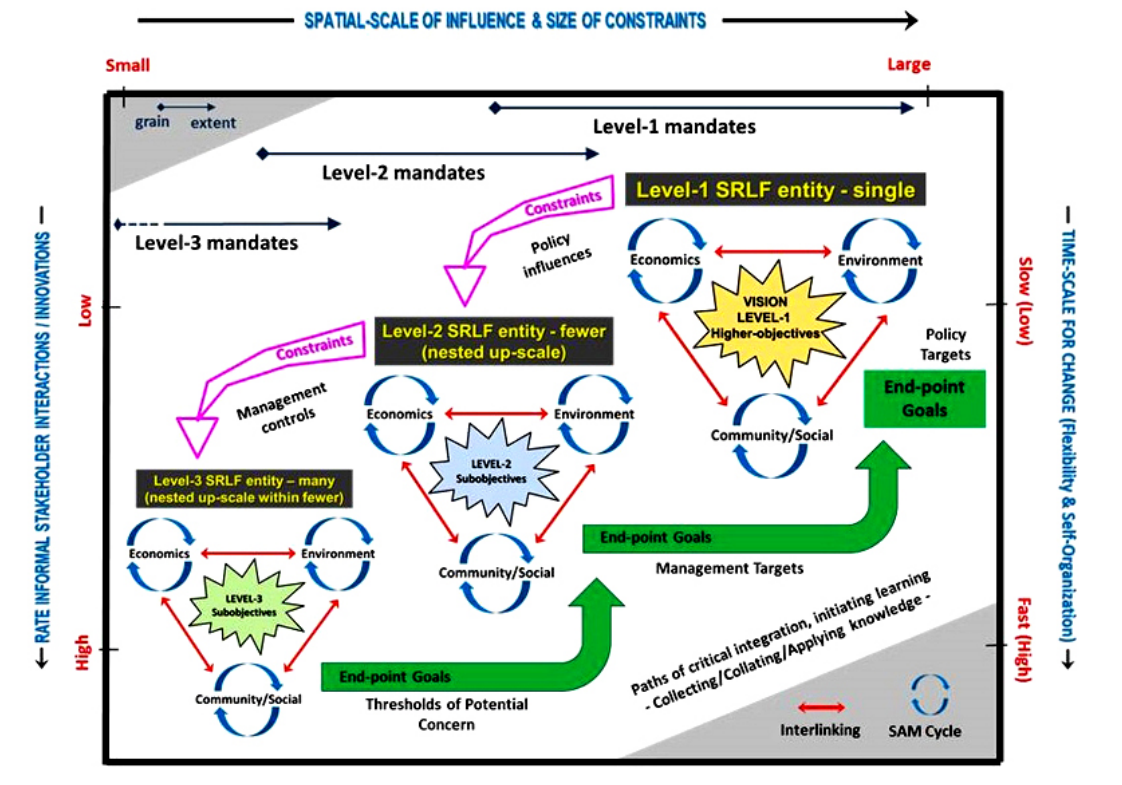
Fig. 2 . The Strategic adaptive management (SAM) Reflexive Learning Framework (SRLF) exhibits a nested, hierarchical structure, across three levels of governance. A SRLF entity comprises interlinked SAM cycles for the Environment, Economic, and Community/Social themes. Typically, there are many Level-3 entities nested within fewer parent Level-2 entities, and these all nest within the single Level-1 entity. The Vision statement, derived at Level-1, is broken down into the Higher-objectives (per theme) at Level-1. These Higher-objectives culminate in Policy Targets at Level-1. Policy Targets cascade down into more detailed Level-2 Subobjectives, culminating in Management Targets at Level-2. Management Targets cascade down into finer detailed Level-3 Subobjectives, culminating in Thresholds of Potential Concern (TPCs) at Level-3. “Top-down” processes in SRLF include policy influences that constrain the types of Level-2 management approaches allowed. In turn, management approaches selected control the types of Level-3 actions required. The main “bottom-up” process involves learning. Learning is initiated primarily during the TPC feedback processes occurring within Level-3 entities. Information/knowledge is collated up to parent Level-2 entities to inform the Management Targets; similarly information/knowledge is collated up to the parent Level-1 entity to inform Policy Targets. Functional attributes pertaining to SRLF entities vary dependent on governance level. This is demonstrated along three axes: the spatial scale of influence and size of constraints imposed on SRLF practitioners and stakeholders; the rate of stakeholder interaction, including development of critical innovations for change; and the time-scale for change, related to the degree of flexibility and self-organization inherent in the stakeholder forums. Additionally, practitioner mandates are defined across the governance levels, represented conceptually by hierarchy “grain” and “extent.” This differentiates practitioner responsibilities and accountabilities (spatially) for applying SAM cycle processes, per level of